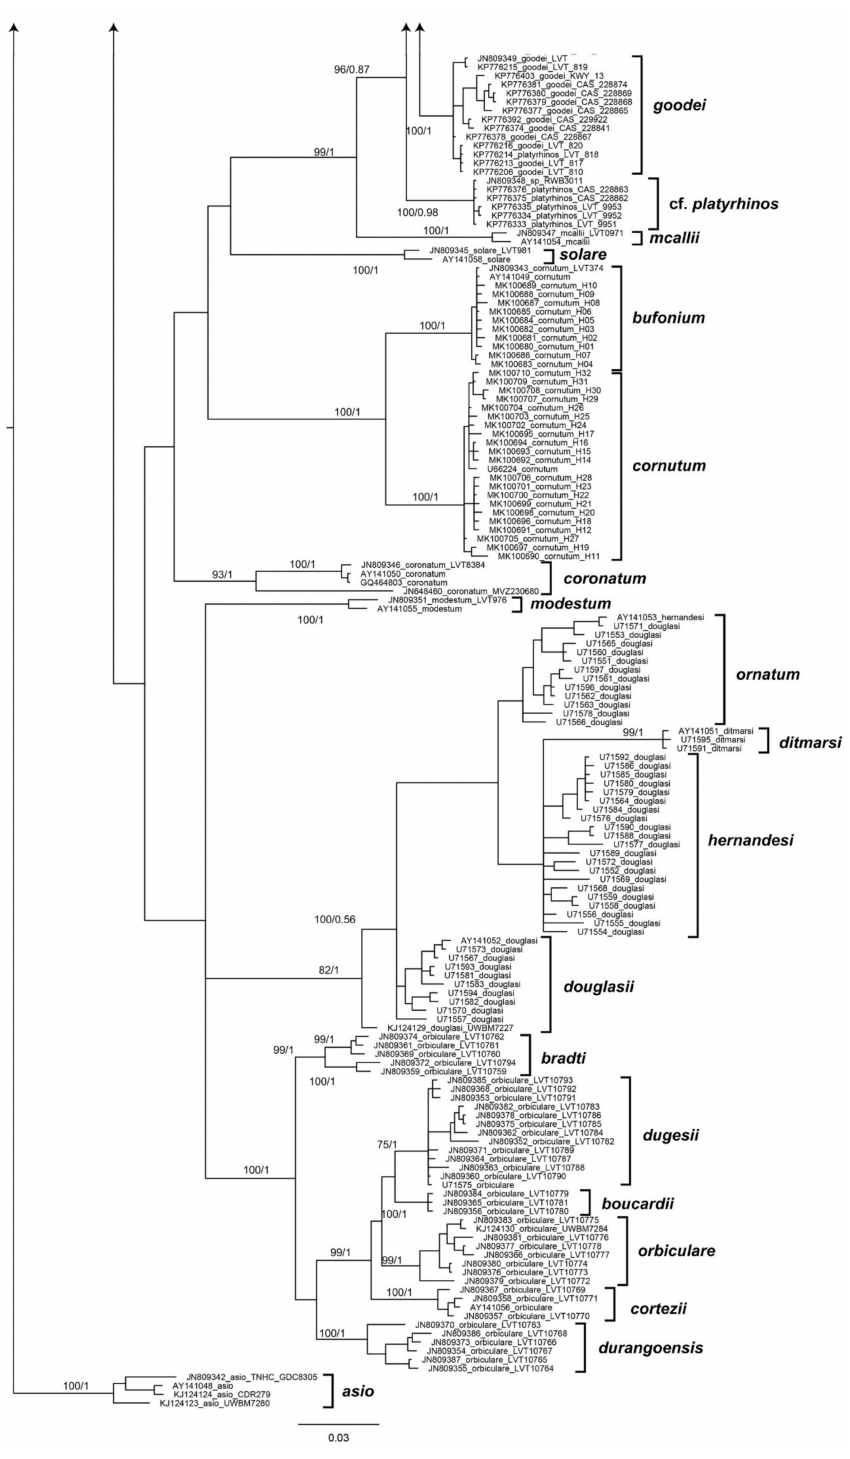
Figure 1. Phylogenetic tree of taxa in the genus Phrynosoma from a Bayesian analysis of the ND4 dataset. A scale bar of genetic distance is indicated. Numbers at nodes are bootstrap values (left) and Bayesian posterior probabilities (right). Only nodes with bootstrap values higher than 75 are shown. Bold names and brackets indicate recognized